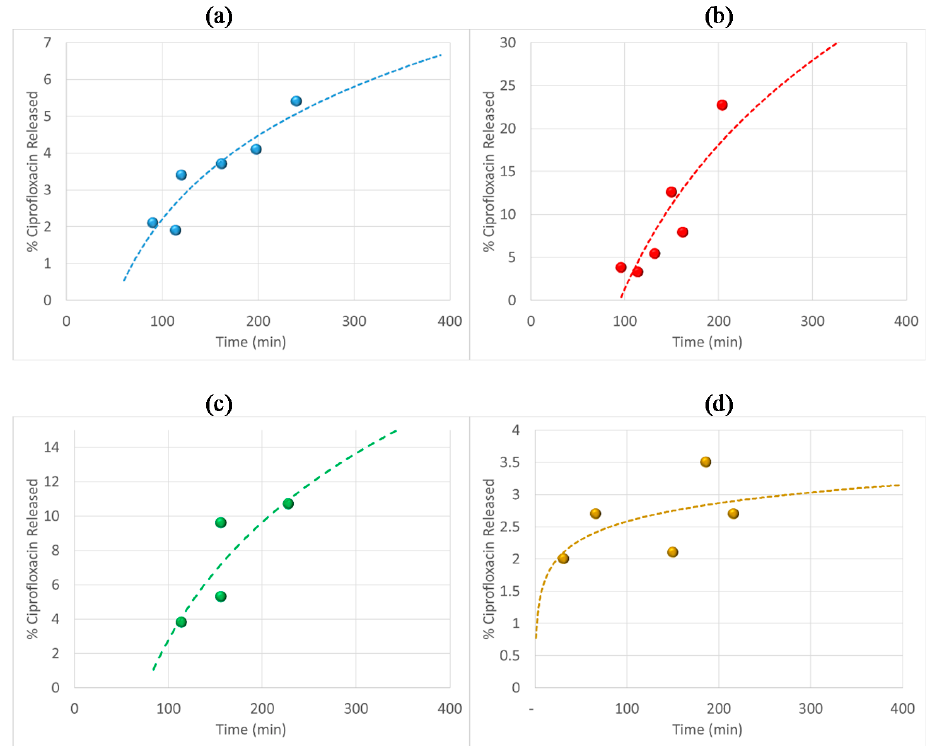
Figure 16. Ciprofloxacin release rate from polymer networks synthetized by FRP. Samples: ( a ) G311; ( b ) G312; ( c ) G313; and ( d ) G314.